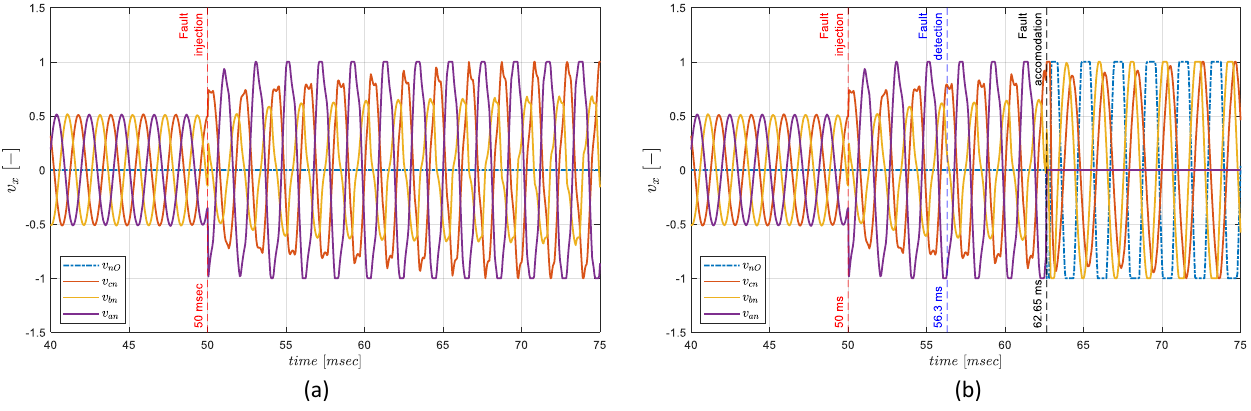
Figure 16. Normalized phase voltages with open circuit on phase a at t = 50 msec ( V lim = 270 V): ( a ) without FTC, ( b ) with FTC.